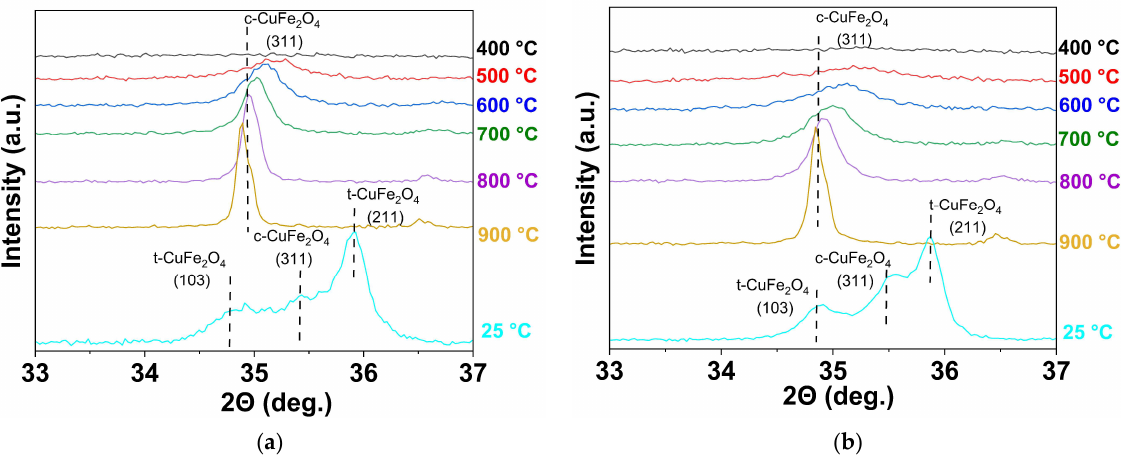
Figure 7. Magnified region of the X-ray diffraction pattern of the as-prepared samples 1 and 2 (( a ) obtained without polysaccharides; ( b ) obtained with dextran-40) in the temperature range of 400–900 °C with the angular spacing corresponding to the main reflection (311) of the cubic CuFe 2 O 4.